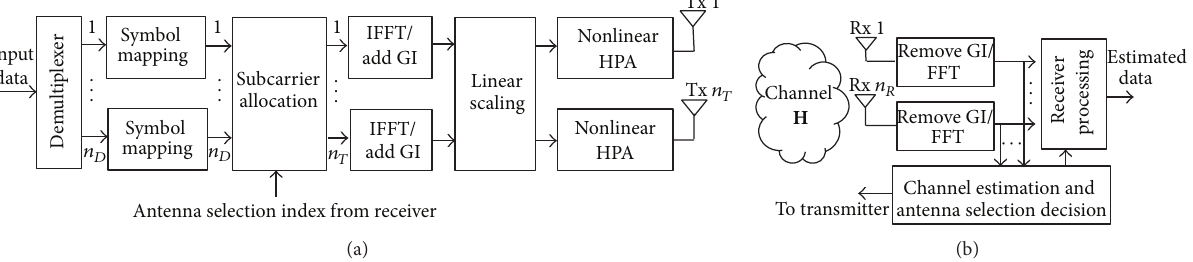
Figure 1: A simplified block diagram of a MIMO-OFDM system with per-subcarrier transmit antenna selection.